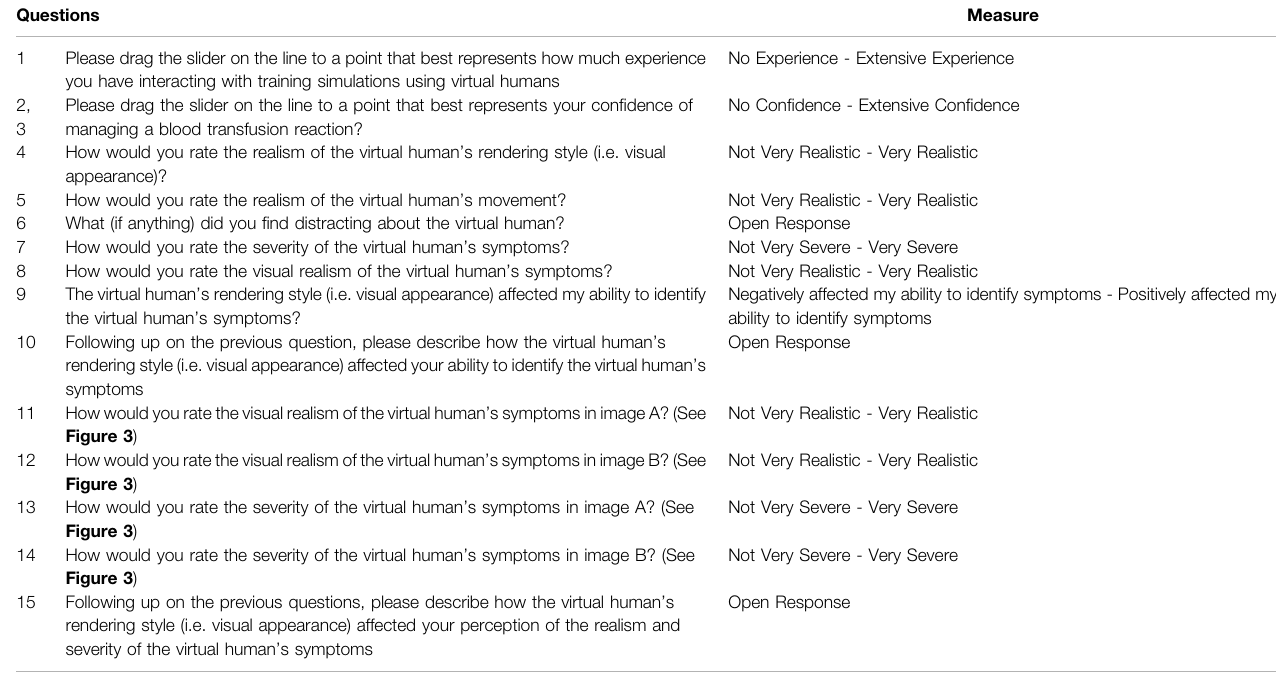
TABLE 1 | Questions asked in the